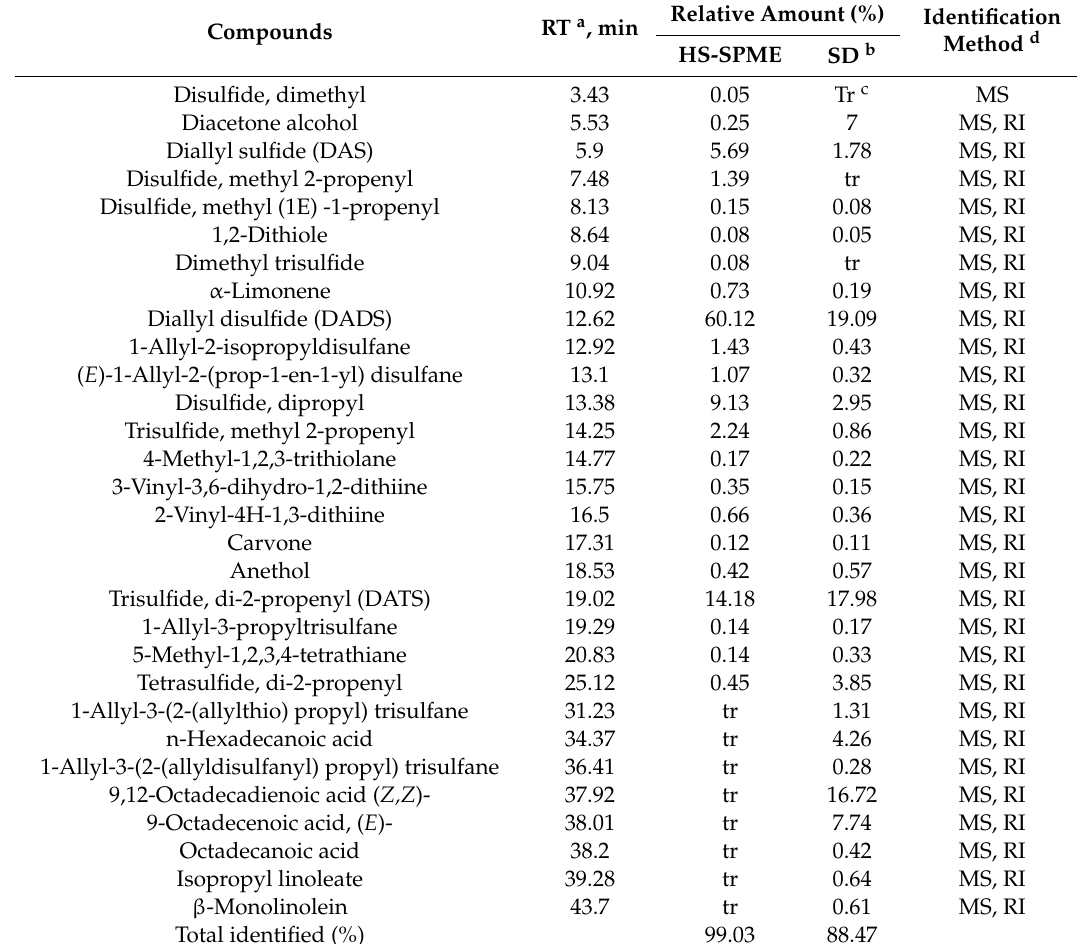
Table 1. Chemical composition of garlic essential oil (GC and GC-MS